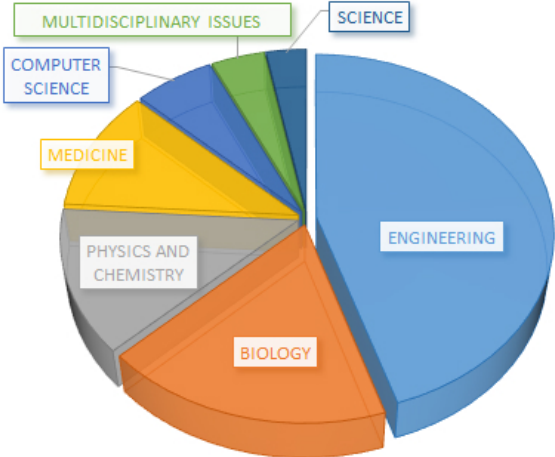
Figure 1. Statistical distribution of 1864 papers concerning “micromanipulation” along seven different groups, gathered over 83 Web of Science